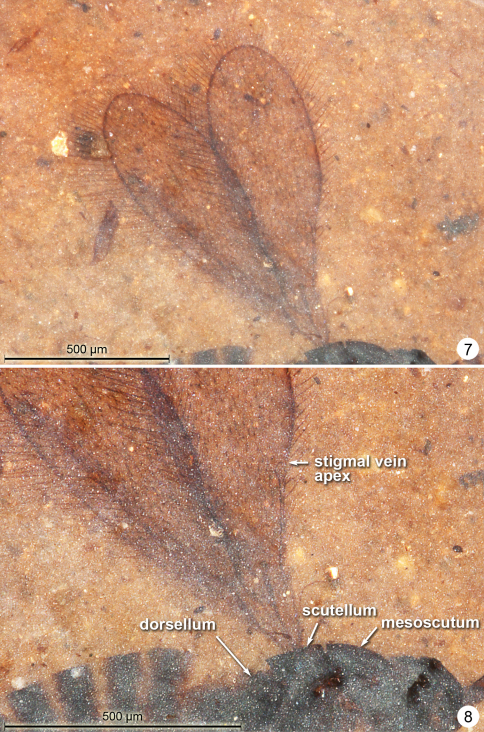
Eoeustochus borchersi, holotype 7 wings 8 mesosoma and base of wings.